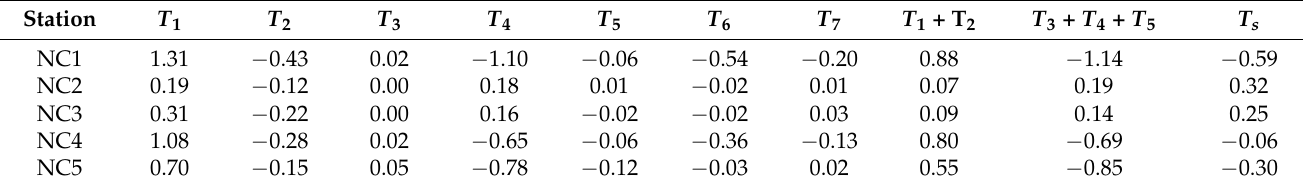
Table 2. Decomposed longitudinal tidally averaged sediment transport rates per unit width (kg s − 1 ) at NC1 to NC5